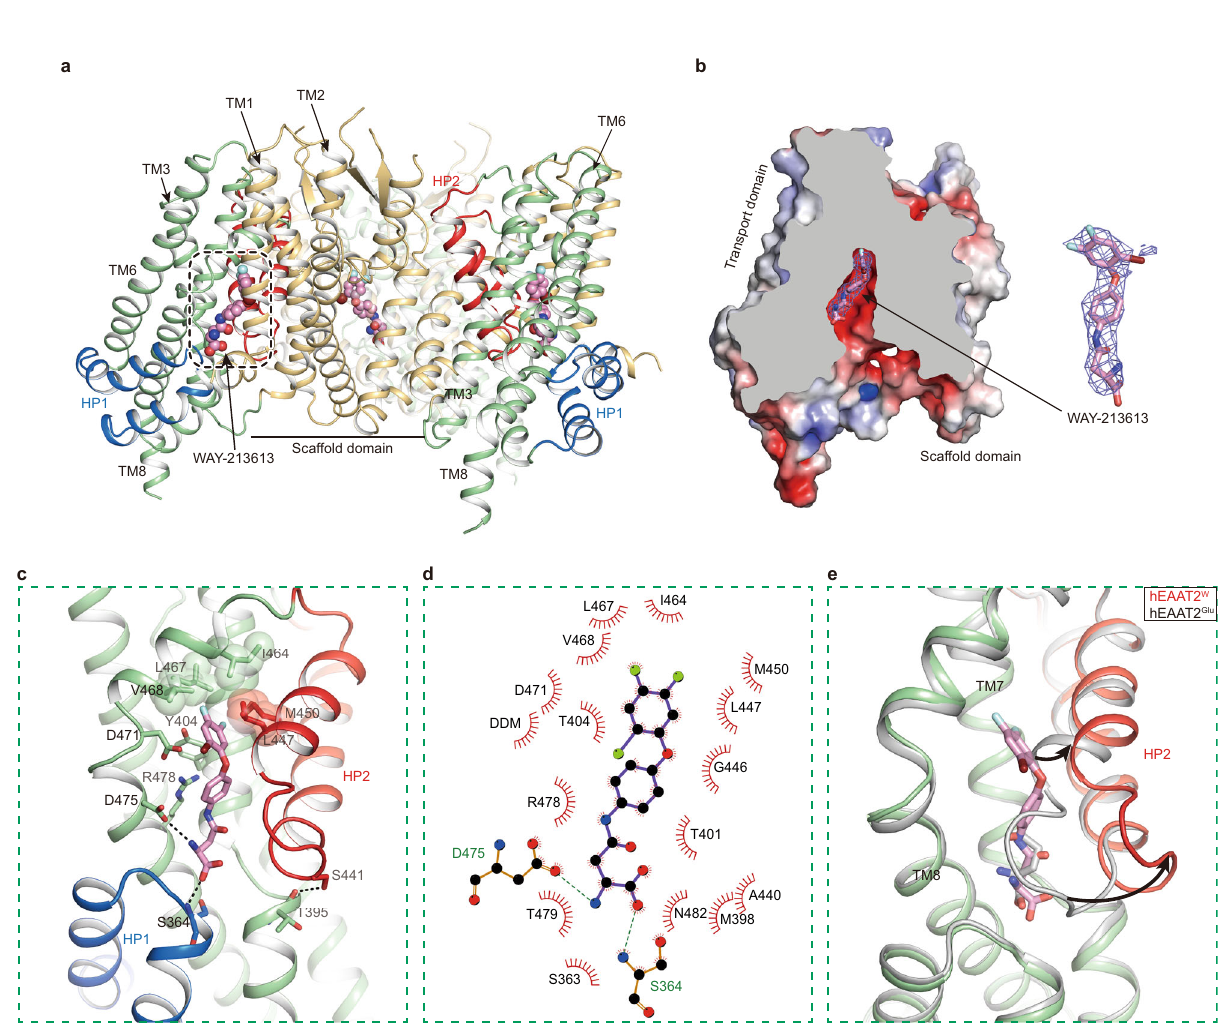
Fig. 3 WAY-213613 binding site of the hEAAT2. a Overall structure of hEAAT2 W viewed from the membrane plane. WAY-213613 is shown as spheres. b Slice through the molecular surface of single protomer of hEAAT2 W . The WAY-213613 is displayed in sticks, and its corresponding EM density is shown in blue mesh. c Detailed binding site for WAY-213613 in hEAAT2 W . The inhibitor WAY-213613 (pink) and the key interaction residues are shown as sticks; the hydrophobic residues of the binding pocket are shown as half-transparent spheres. d 2D plot representing the interactions of WAY-213613 with its surrounding residues by LigPlot + . e Conformational changes of the glutamate binding site between hEAAT2 W (pale green) and hEAAT2 Glu (gray). The HP2 of hEAAT2 W is highlighted in red and black arrows indicate the shift of the